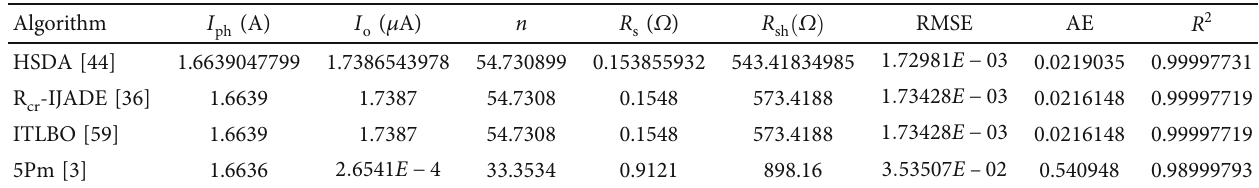
Table 6: The parameters and statistical tests for the STM6-40 photovoltaic panel.